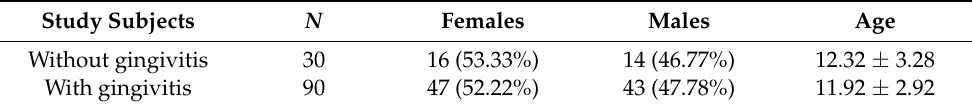
Table 1. Gender and age structure of study participants with and without gingivitis. Study Subjects